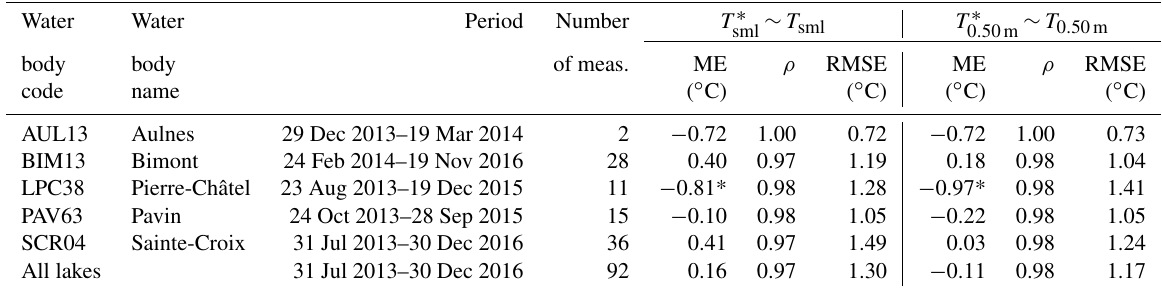
Table 1. Comparison of satellite-based temperature estimations made using the algorithm by Jiménez-Muñoz et al. (2009) and corrected for skin and warm layer effects ( T ∗ and T ∗ ) to in situ measurements (temperature at 0.50 m, T 0 . 50m , and average temperature of the sml 0 . 50m surface mixed layer, T sml ). ME is the mean error (satellite – field data), ρ is the correlation coefficient and RMSE is the root mean square error. ME statistically different from zero at α = 0 . 05 are indicated with an asterisk.